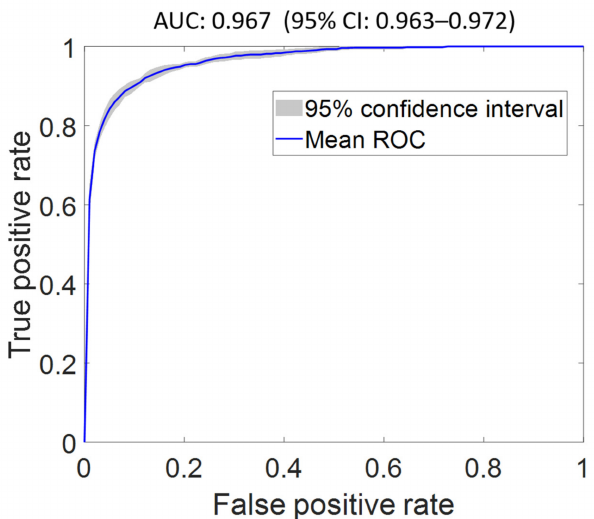
Figure 1. Optimal receiver operating characteristic curve of mortality classifier using the optimal feature set (FS2) as input. The proposed model achieved an AUC of 0.967 (95% CI: 0.963–0.927), which is superior to the AUC of the classifier using all features (FS1) as input.